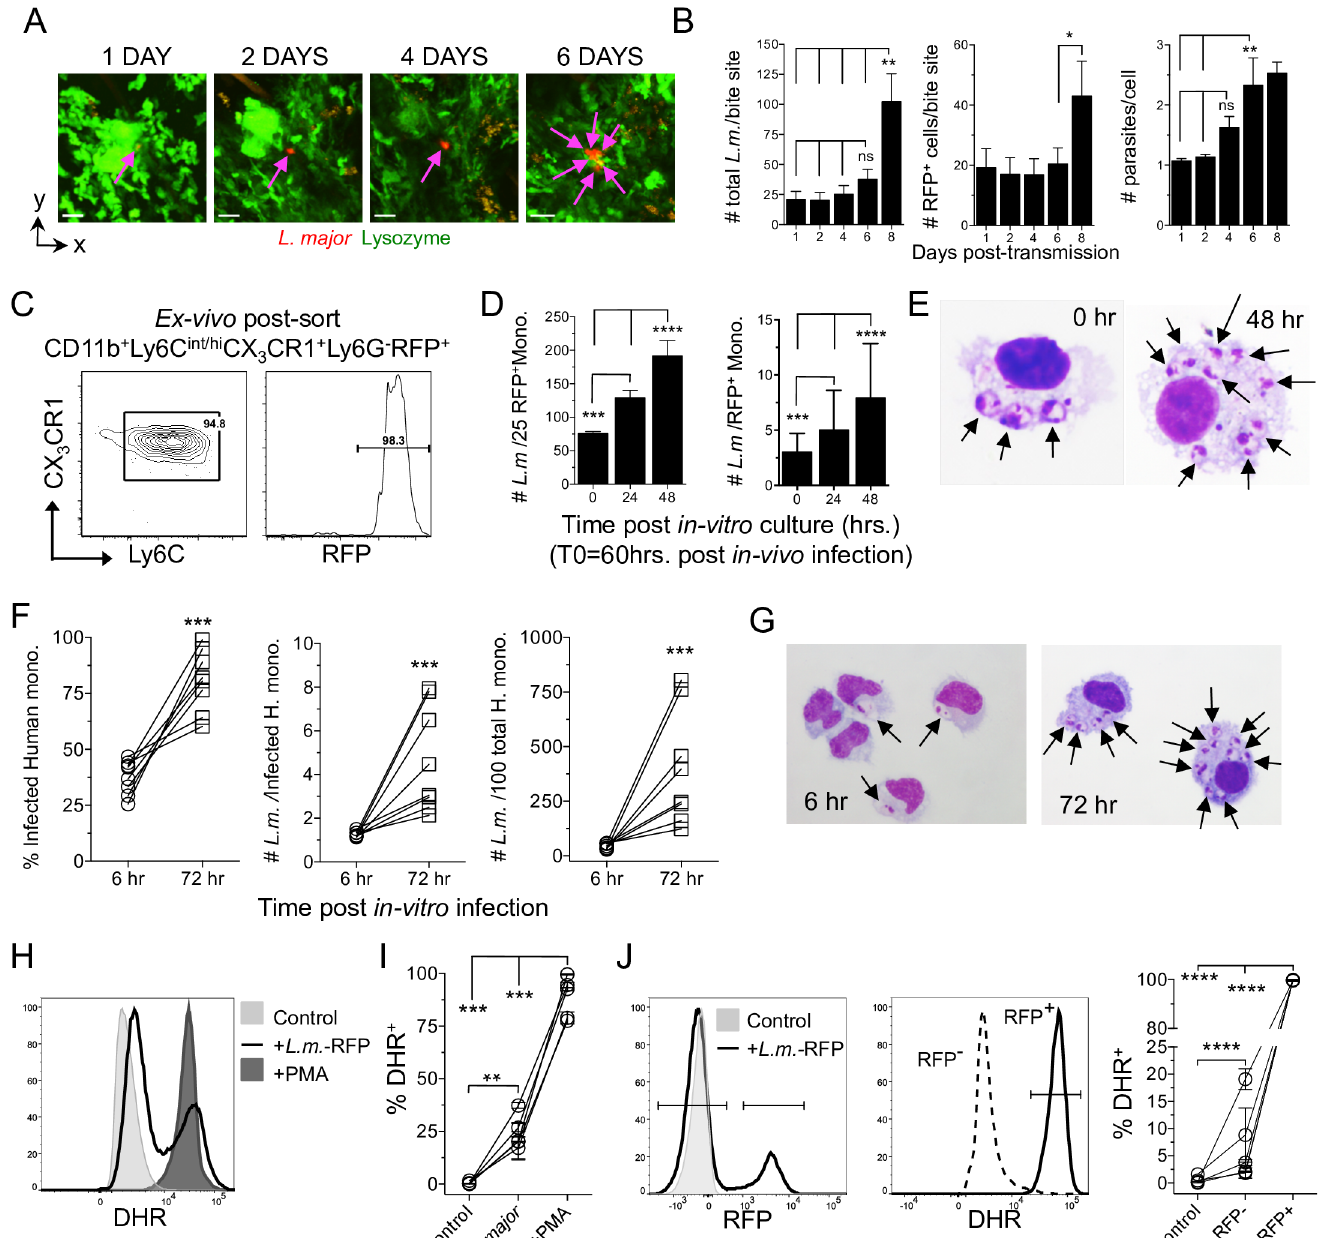
Fig 2. L . major undergoes delayed proliferation until transitioning into monocytes that are permissive for parasite replication. (A and B) LysM- gfp mice were exposedto the bites of L . major- RFP infected sand flies and individualinoculation sites were sequentially imagedemploying2P-IVM. (A) Representative images from the same bite site of a putative singleinfected cell from 1 to 6 days post-bite. (B) Enumeration of the number of parasites and infected cells (parasites are assumed to be intracellular) per individual bite site employingslice-by-slice visual analysisof the z-stack to determine parasite and infected cell number. Data are the Mean +/- SEM, n = 7 bite sites. (C-E) CX 3 CR1-gfp mice were needleinoculatedwith 2x10 5 L . major -RFP parasitesin the ear. Sixty hours post-infection CD11b + Ly6C int/hi CX 3 CR1 + Ly6G - RFP + cells were cell-sortedand placedin in-vitro culture. (C) Post-sort analysisof the RFP + sorted population. (D) Quantitative cytospin analysisof the total number of amastigotes per 25 RFP + monocytes(left panel; 100 total monocytes per time point, a denominator of 25 was chosen arbitrarily) or the numberof amastigotesper individual monocyte (right panel; n = 100 (d0); 123 (24h) or 179 (48 h), total monocytes). Data are the mean +/- SD. Data are from one experiment representative of 3 similar experiments. (E) Representative cytospin images at 0h and 48h of RFP + murine monocytes. (F-J) In-vitro L . major infection of human elutriatedmonocytes. (F) Percent infected, number of parasites per each infected, and total number of L . major per 100 total, monocytes. Each data set is an individualexperiment employingan individualdonor (n = 8), employing (cid:21) 108 infected monocytesper time point per donor. (G) Representative cytospin images. (H-J) Respiratory burst in humanmonocytes employingDHR. (H) Representative histogram of DHR expressionby total elutriatedmonocytes under the